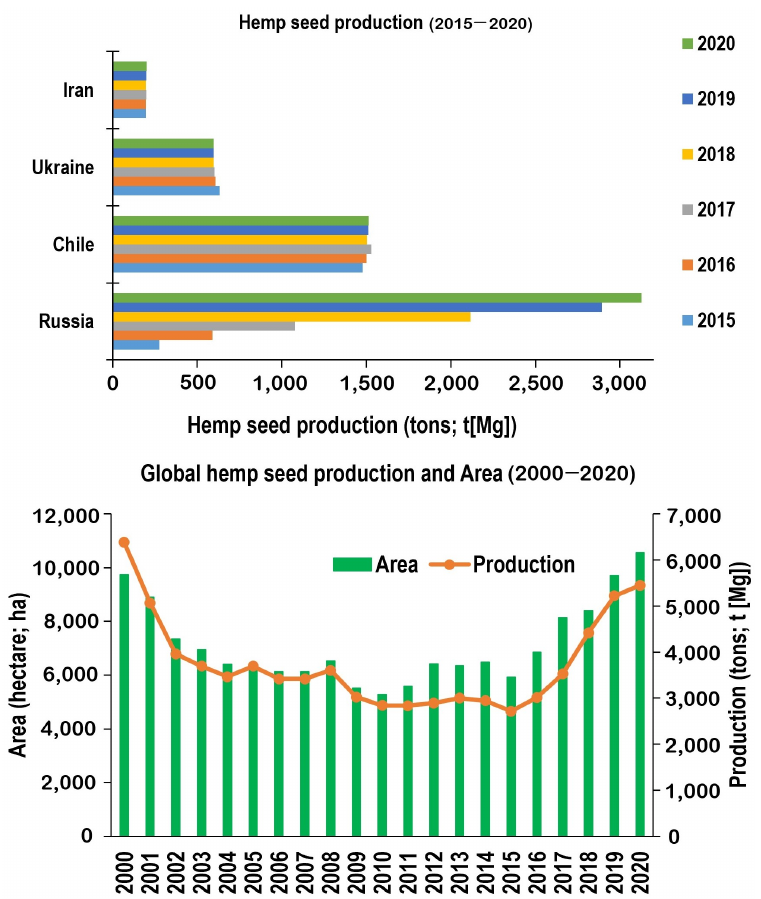
Figure 1. Trend in global hemp seed production (2015–2020) and area (2000–2020), based on data from